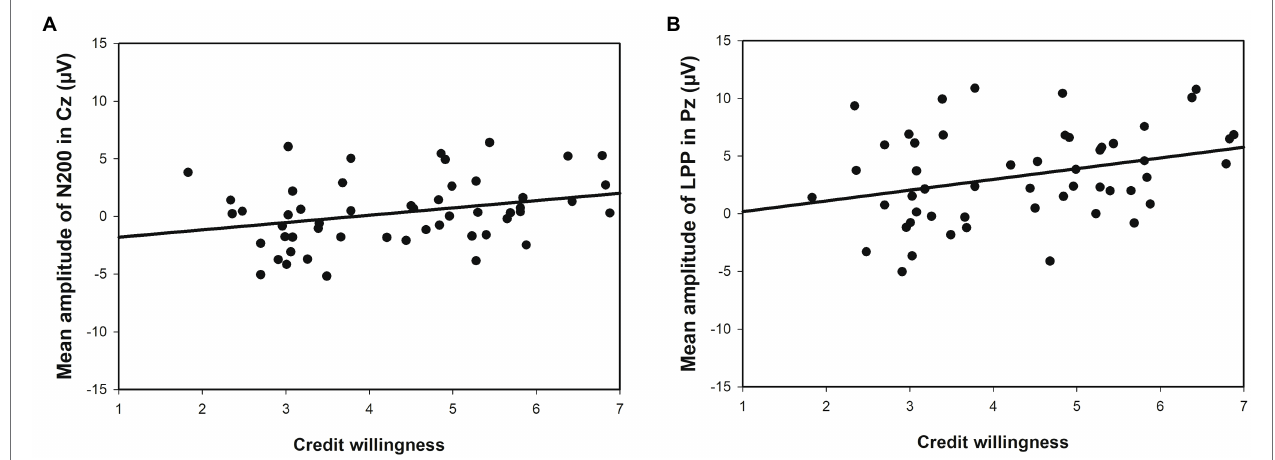
FIGURE 5 | Correlation between amplitudes of N2 or LPP and credit willingness: (A) Linear correlation between the mean amplitude of N2 at the Cz electrode and credit willingness; (B) Mean amplitude of LPP at the Pz electrode and credit